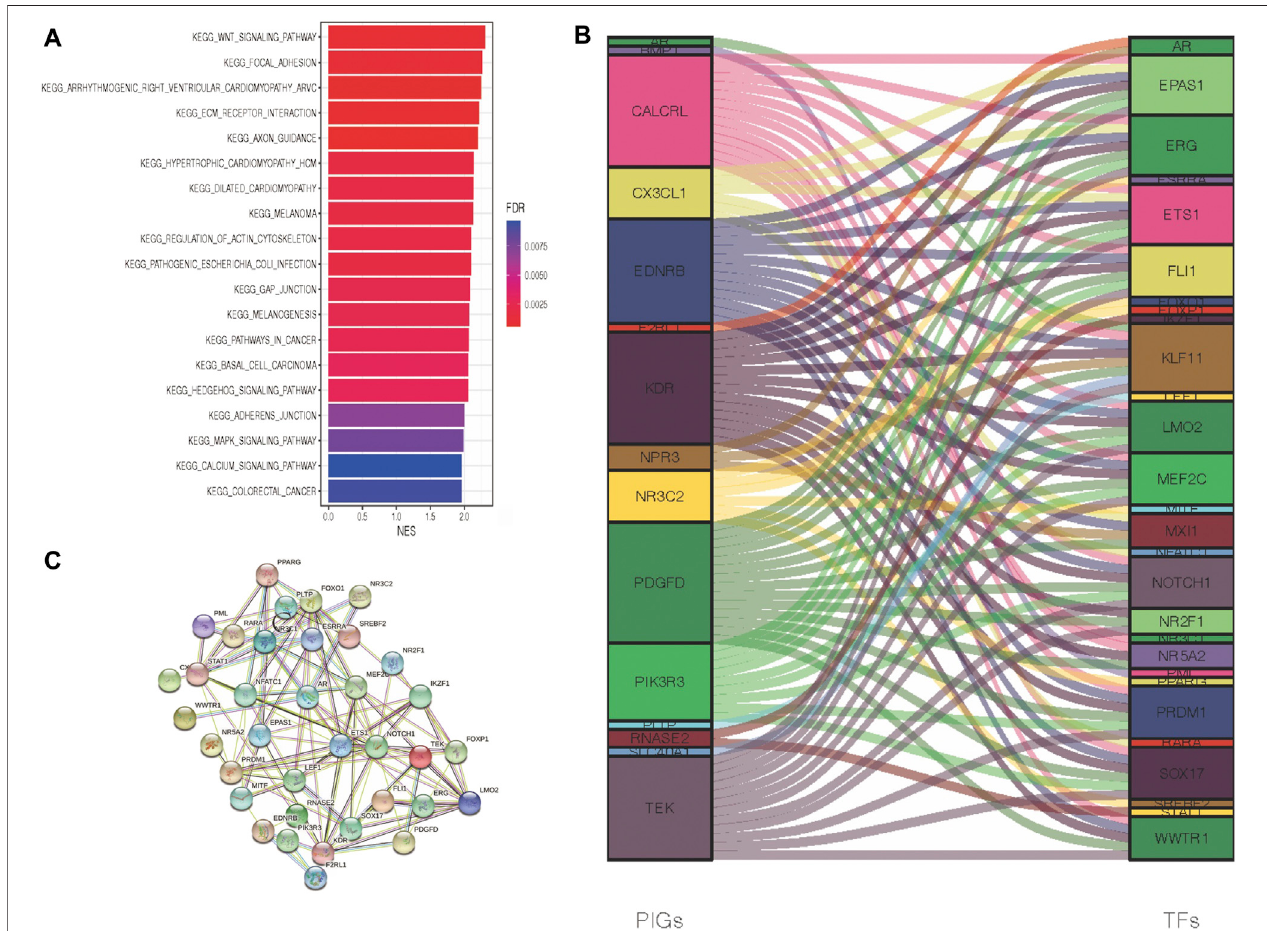
FIGURE 3 | Crosstalk networks and pathway characterization between each of the two immune subtypes. (A) GSEA and KEGG analyses between DEGs of two immune subtypes. (B) TF and PIG regulatory crosstalk were displayed via an alluvial diagram. (C) PPI network between TFs and PIGs.